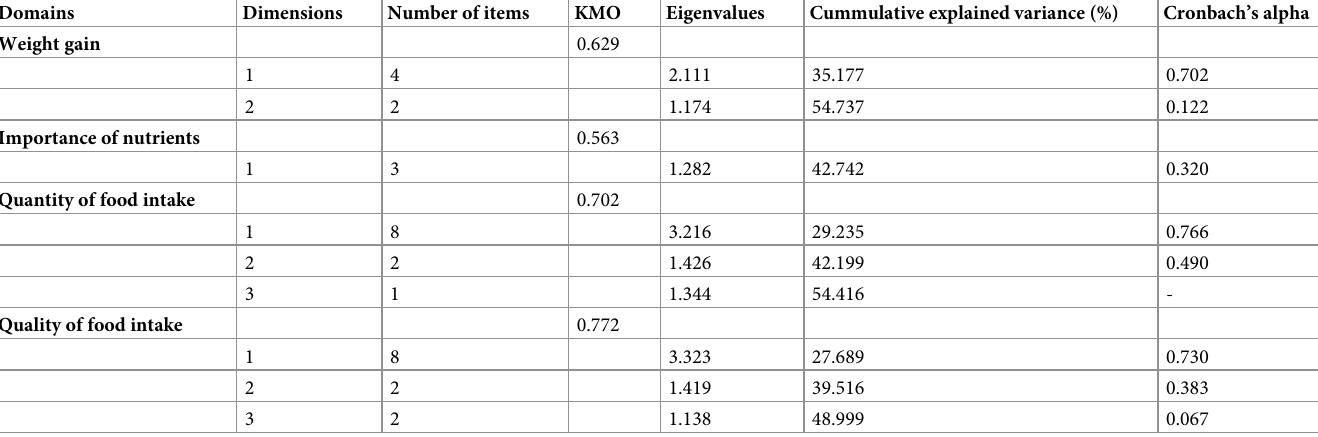
Table 3. Summary of factor analysis and reliability analysis results for all four domains of the questionnaire.